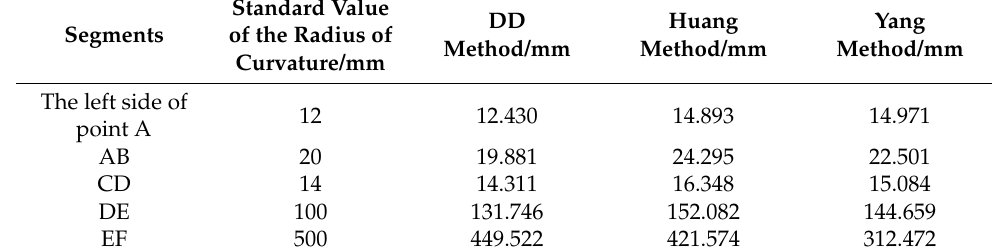
Segments Table 6. The results of calculating JM-type profile’s radius of curvature.